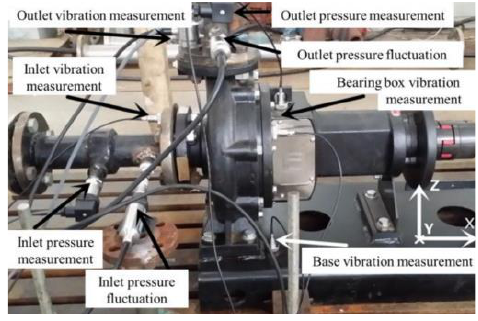
Figure 17. Sensor measurement point layout [78].